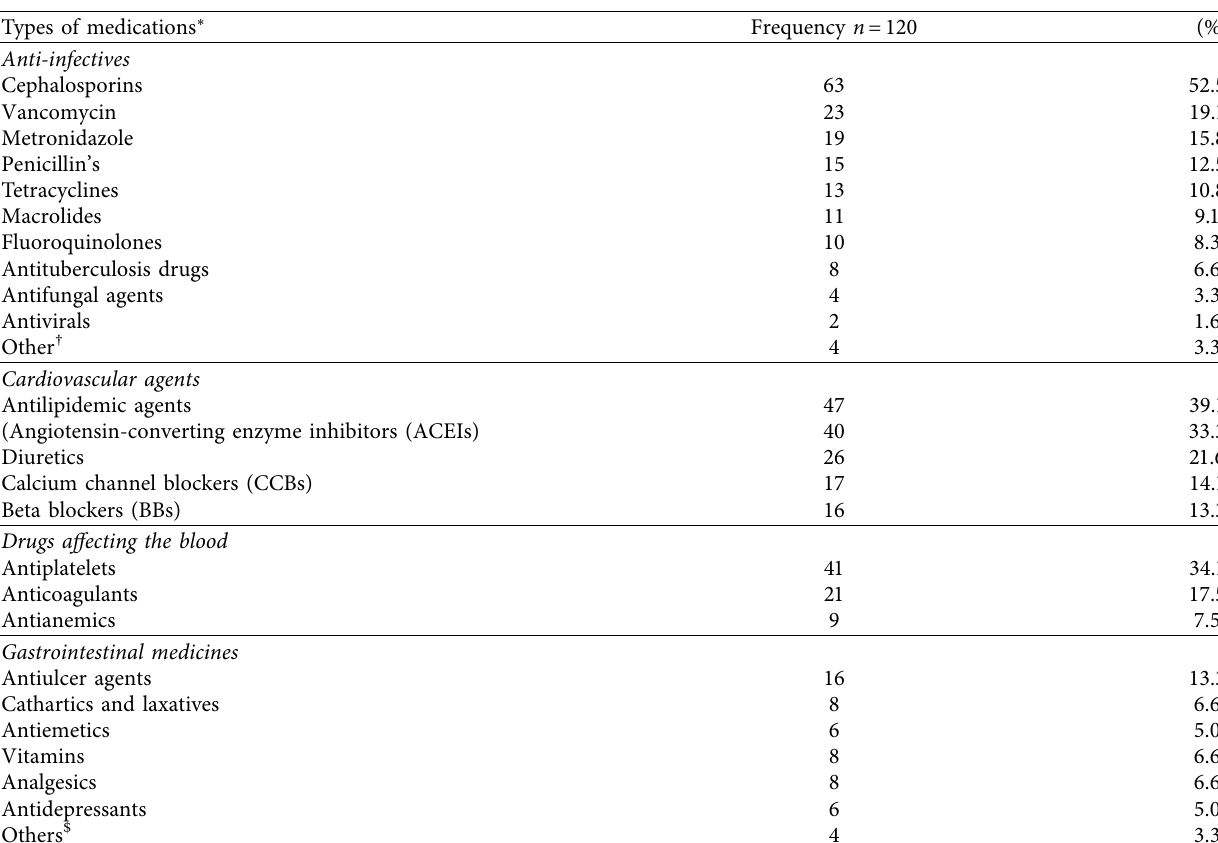
Types of medications